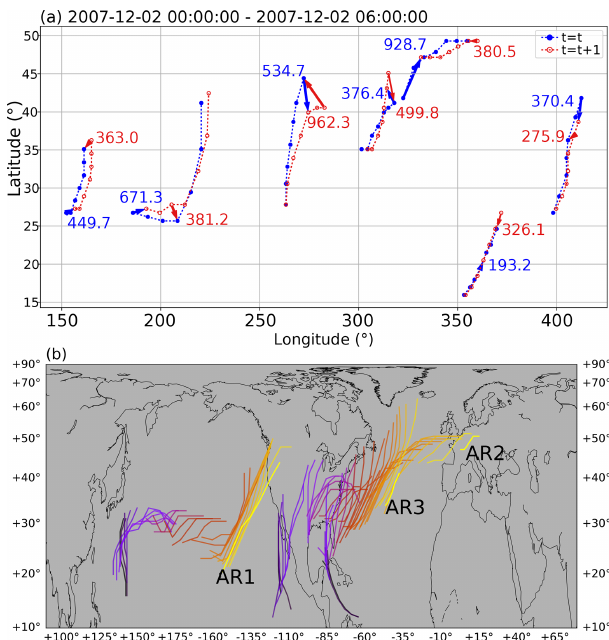
Figure 7. (a) Tracking of ARs across 2 December 2007 at 00:00 and 06:00UTC using the nearest neighbor algorithm. ARs on 2 De- cember 2007 at 00:00UTC are represented by their anchor points joint by dashed lines and are drawn in blue, and ARs on 2 Decem- ber 2007 at 06:00UTC are drawn in red. Blue (red) arrows indicate the forward (backward) Hausdorff distance among paired ARs, and the distances (in km) are labeled nearby. (b) Tracks of three selected ARs represented by their axes. The life cycle of an AR is repre- sented as the black–yellow transition in the coloring. Other ARs during the same period are omitted for brevity.